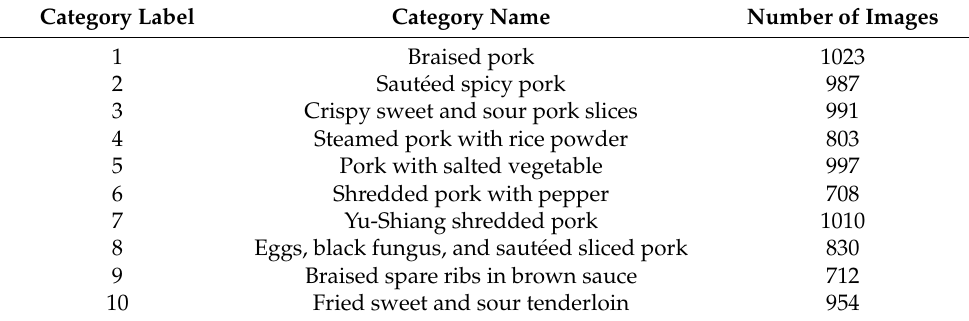
Table 3. Image number for each category of food items for VIREO-Food-172